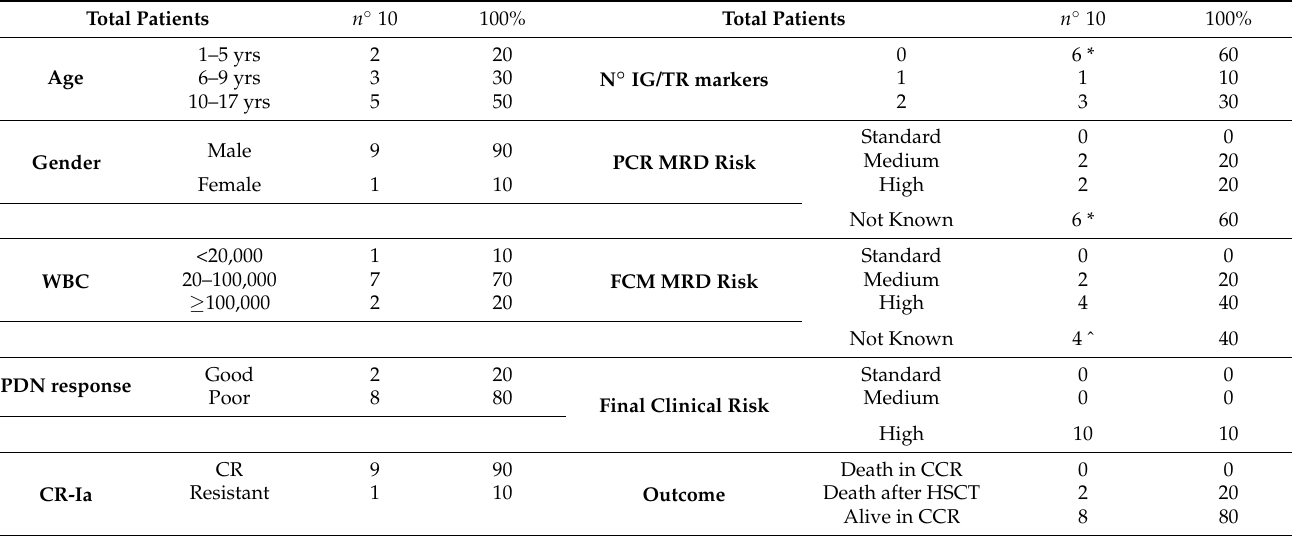
Table 1. Characteristics of children with FLT3-ITD positive ETP, enrolled in AIEOP protocols. Total